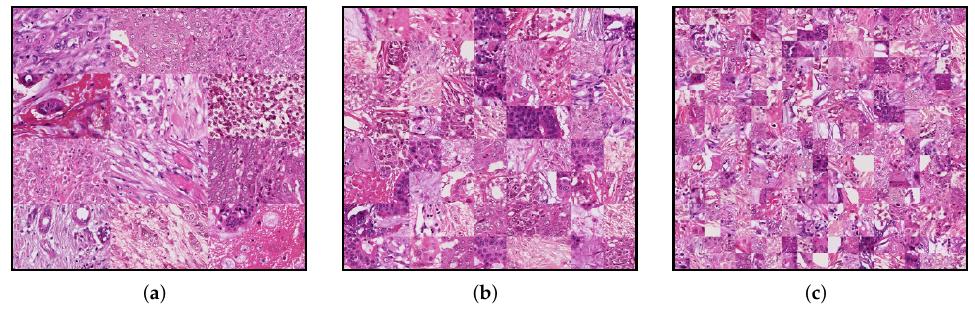
4 tiles, (b) 4 tiles, × × 513 (a), 513 ( a ), × ×